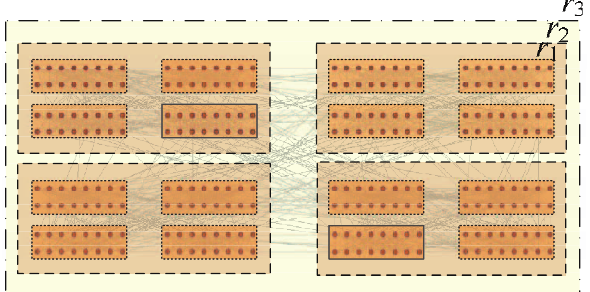
Figure 9. Schematic networks with hierarchical structures. Each of the four large clusters is made out of 64 vertices and has an internal subdivision in four clusters with 16 vertices.